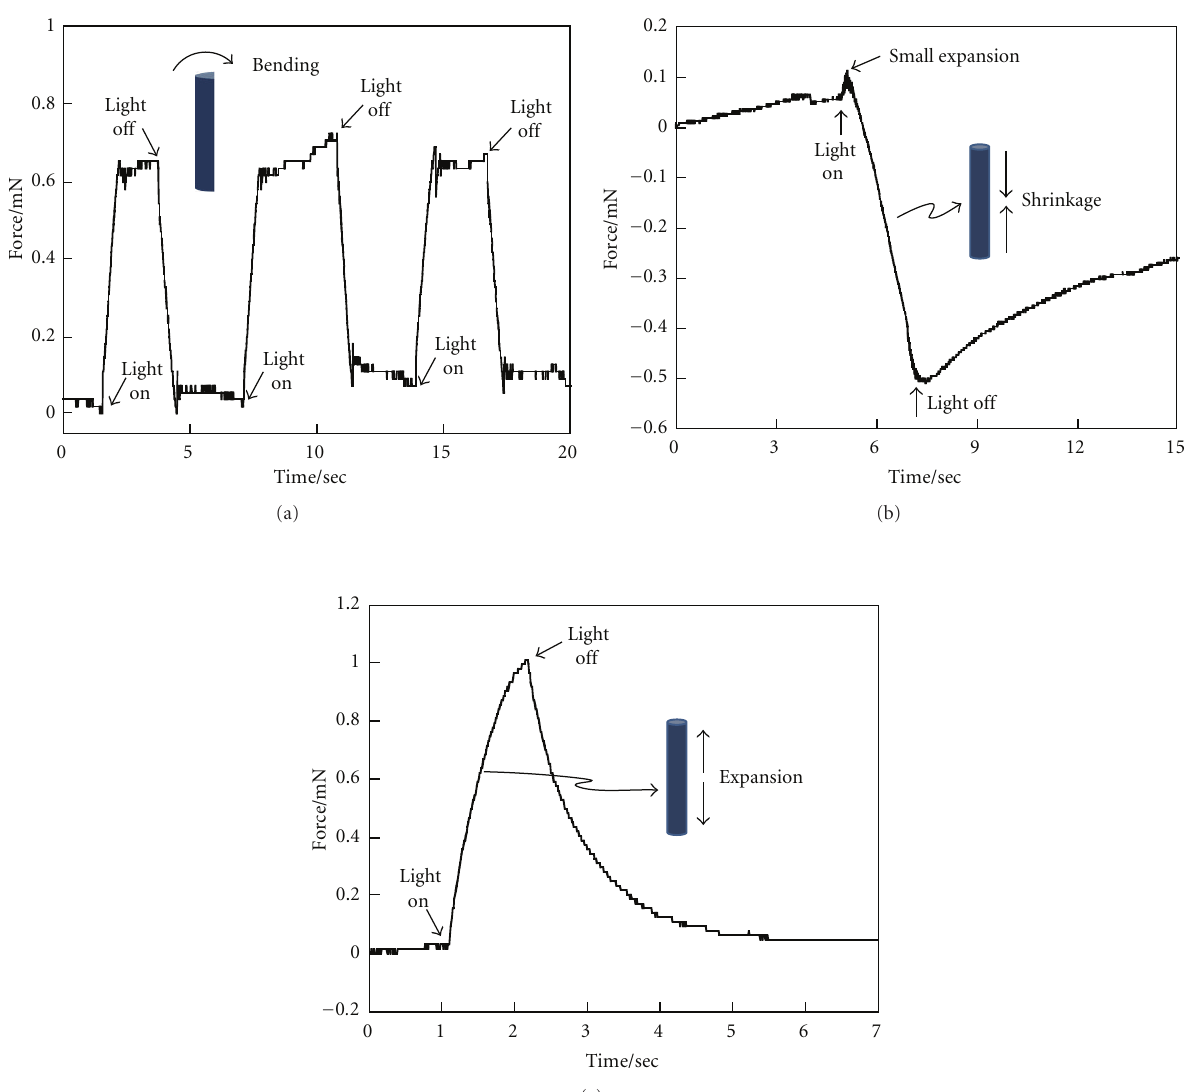
Figure 4: Measurements of mechanical force for (a) semicircular PAA/MB fiber, (b) round PAA/MB fiber, and (c) round PS/MB fiber.